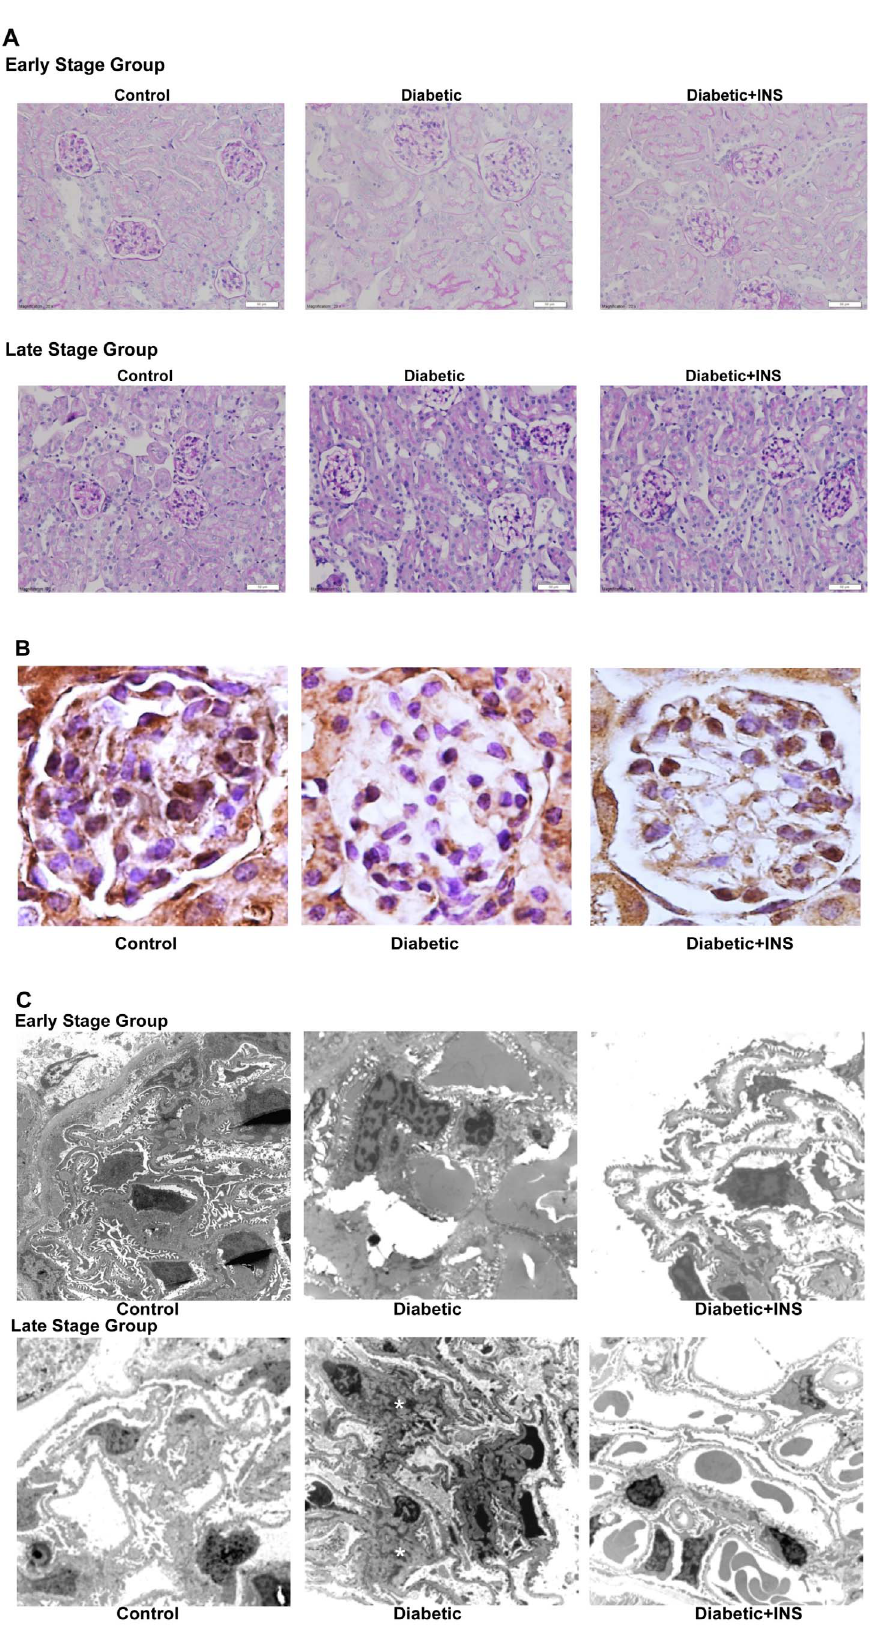
Figure 2. A. Representative micrographs of periodic acid–Schiff (PAS)-stained kidney sections. Upper panel: Diabetic, Diabetic-INS early stage of diabetes and Control mice. B: Lower panel: Diabetic, Diabetic-INS late stage of diabetes and Control mice. B. Podocyte number in